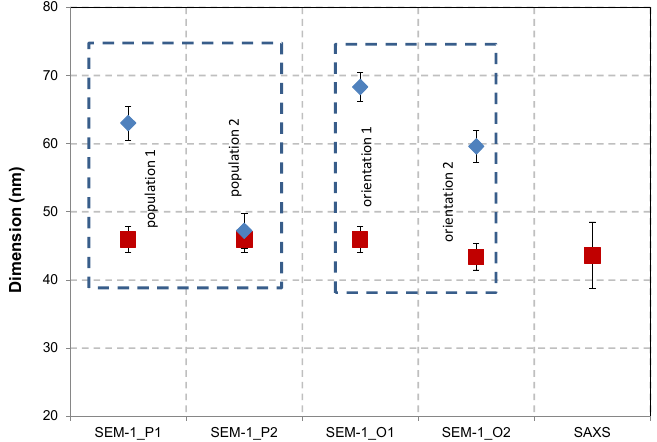
Figure 9. Parameters s (red) and L (blue) measured by SEM ( D MaxFeret and D MinFeret ) as a function of their aspect ratio (left box, 2000 NPs, population P1 and P2) and their orientation (middle right box, 250 NPs, orientations O1 and O2). The SAXS results ( s SAXS ) are added for comparison; a L SAXS value was calculated by using the aspect ratio deduced from microscopy data. The uncertainty bars (k = 2) are also given together with the mean value.